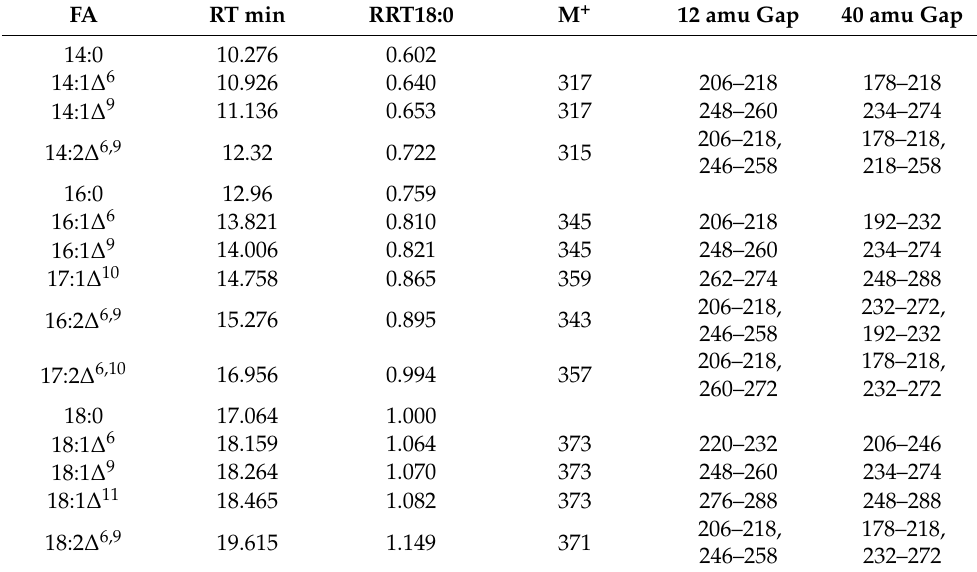
Table 2. Chromatographic features of FAMEs and mass-spectrometry features of 3-pyridilcarbinyl derivatives of FAs from cell S. elongatus PCC 7942 transformed with the desD ( sll0262 ) gene and grown in presence of potassium salt of cis -10-heptadecenoic acid (17:1 ∆ 10 ). RT—retention